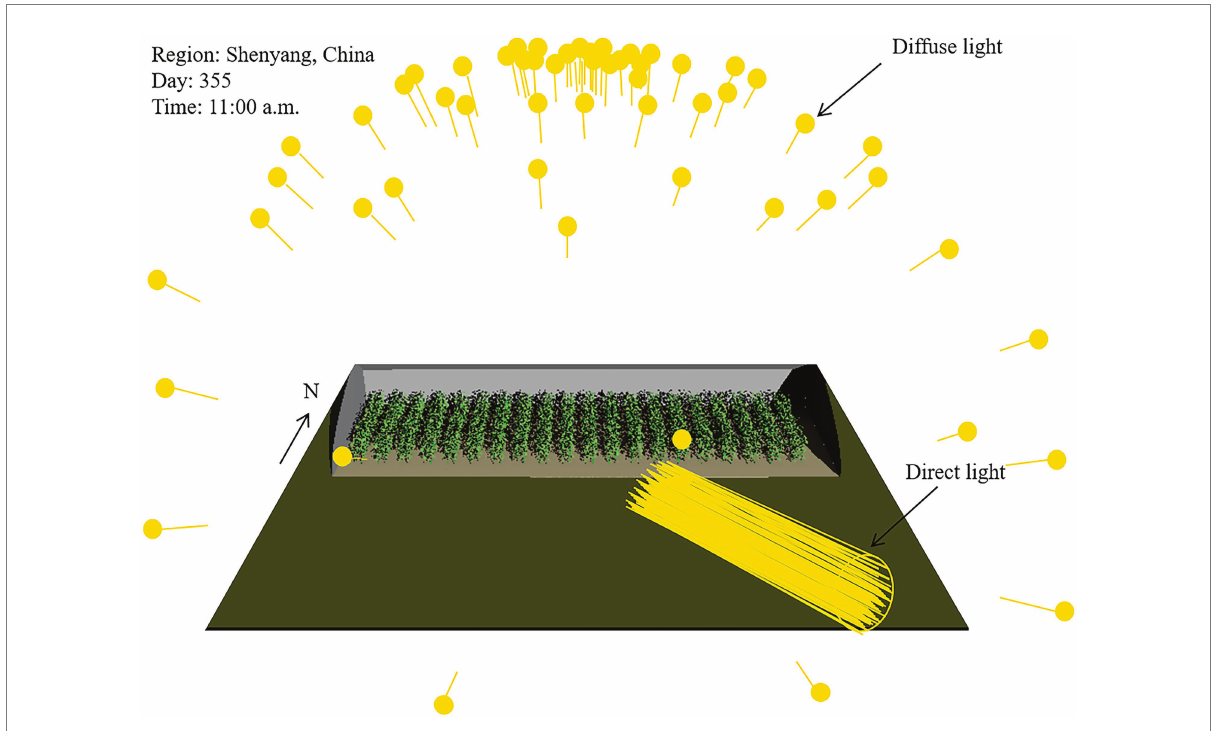
FIGURE 3 Snapshot of the virtual greenhouse model with a tomato plant population of 760 plants arranged in 19 horizontal rows and 40 vertical columns. Indicated in yellow, the position of the light sources of the diffuse light sky and the direct sun module generating together the solar radiation scenario for the